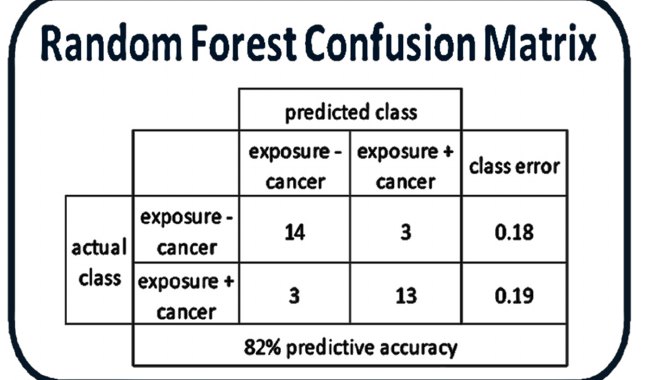
Figure 7. Random forest confusion matrix and biochemical importance plot. Confusion matrix for Hemangiosarcoma and